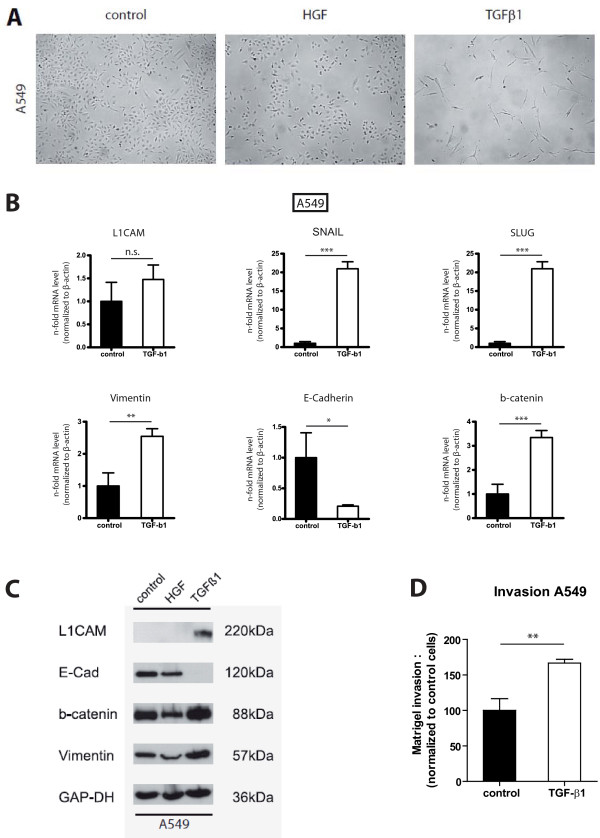
L1CAM in A549. A) Stimulation of A549 cells with TGF-beta1 induces a mesenchymal phenotype whereas HGF does not alter cell morphology. Note that TGF-beta1 treatment affected the proliferation of A549 cells. B/C) A549 cells stimulated with TGF-beta1 show an EMT phenotype and increased L1CAM expression on mRNA and protein level. One representative experiment of n = 3 is shown. GAP-DH loading control. D) Matrigel invasion of A549 cells is enhanced by TGF-beta1 stimulation. The error bars represent mean values ± SEM. One representative experiment of n = 3 is shown.